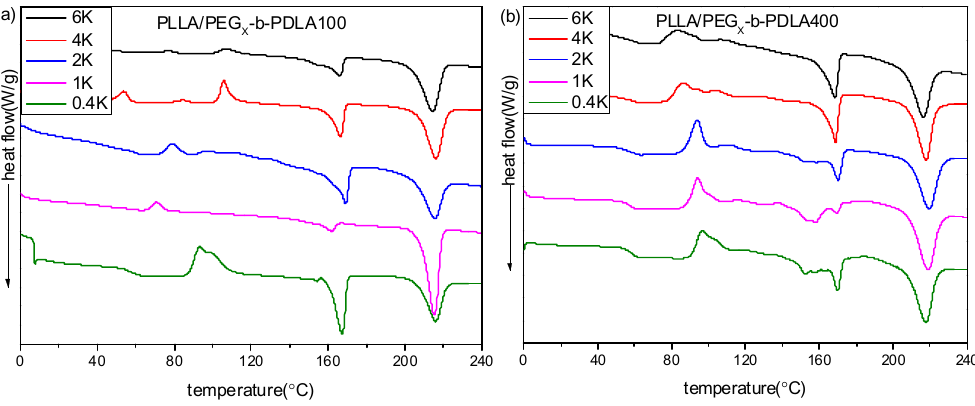
Figure 5. DSC heating curves of blends with different PEG blocks after quenching from 240 °C: ( a ) PLLA/PDLA-PEG 1k -PDLA100; ( b ) PLLA/PDLA-PEG 4k -PDLA400.